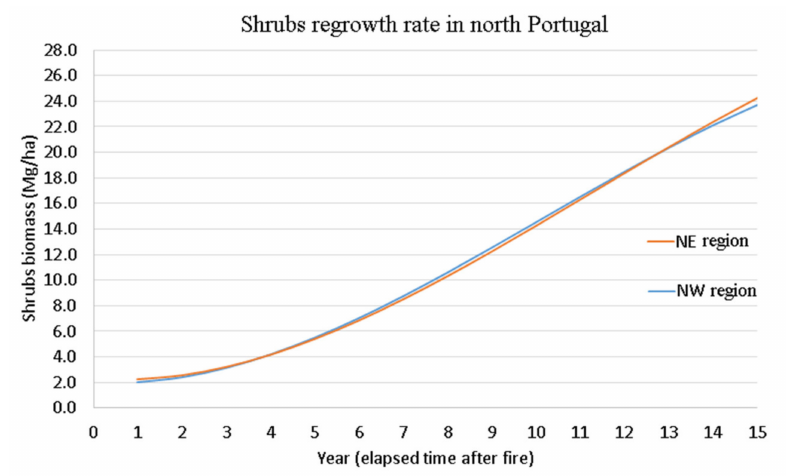
Figure 9. Estimations for shrubs regrowth rates in the study area.